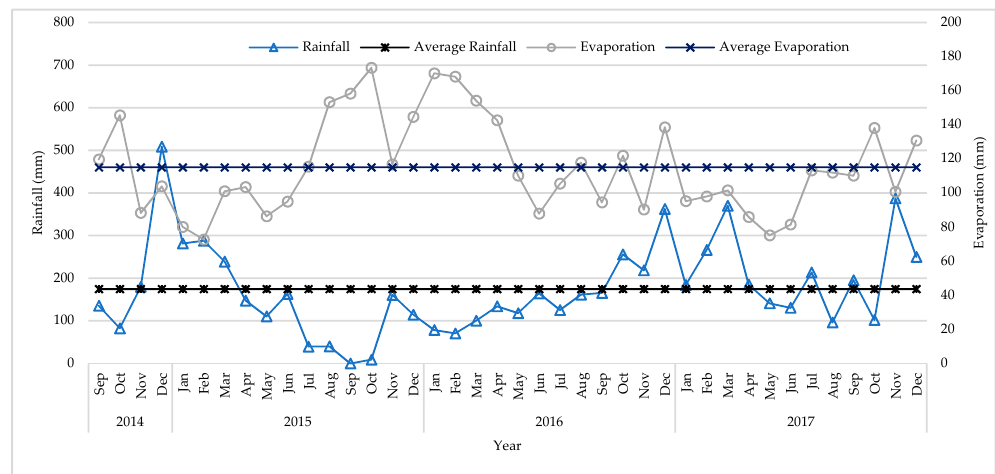
Figure 8. Total monthly rainfall and evaporation.